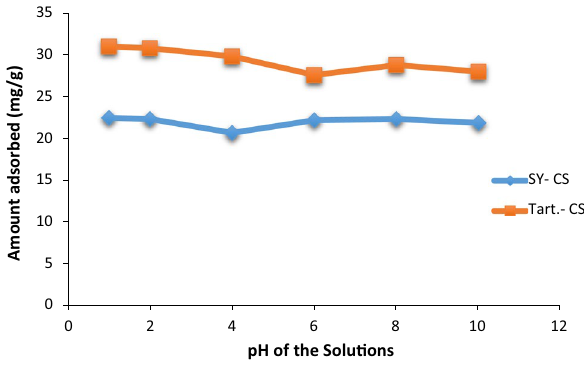
Fig. 3 Effect of solution pH on the amount of dyes (sunset yellow